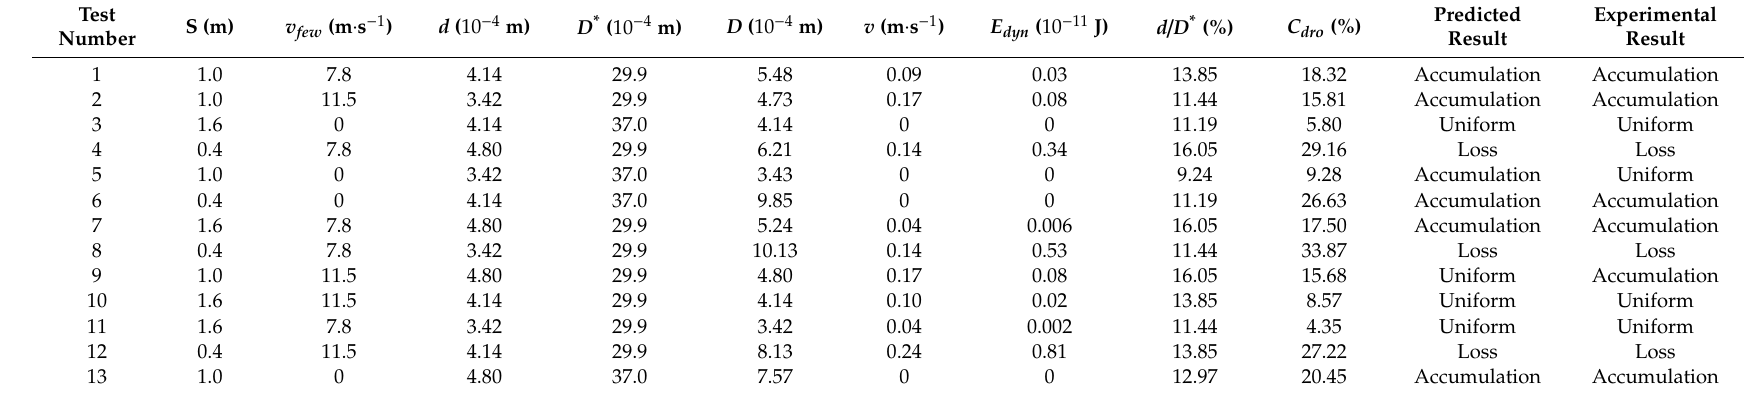
Table 3. Predicted and actual states of deposition of droplets on the obverse of Citrus leaves under di ff erent combinations of operating parameters.